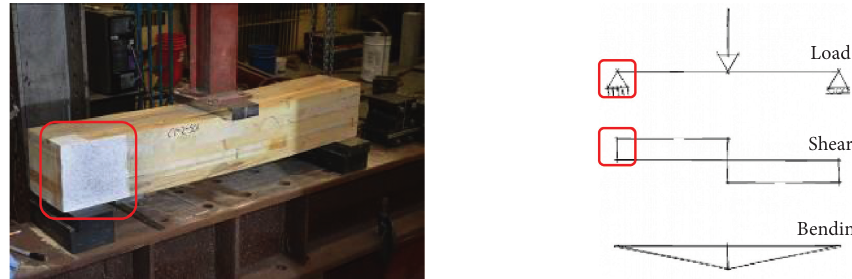
Figure 2: DIC area in shear test and related shear diagram.